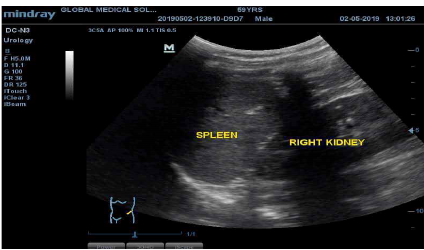
Figure 4: Transverse sonogram without Colour Doppler of the epigastrium. The head of the pancreas on the left side and a gas filled stomach on the right side. Abdominal aorta (AO) on the right side and inferior vena cava (IVC) on the left.